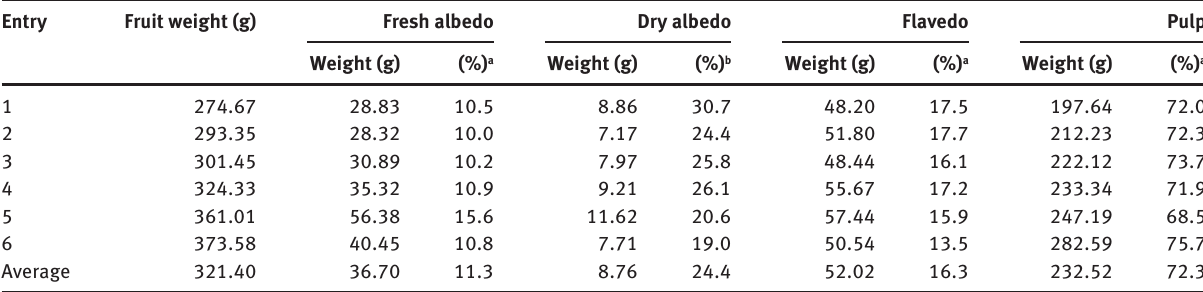
Table 1: Grapefruit composition data and albedo weight loss upon